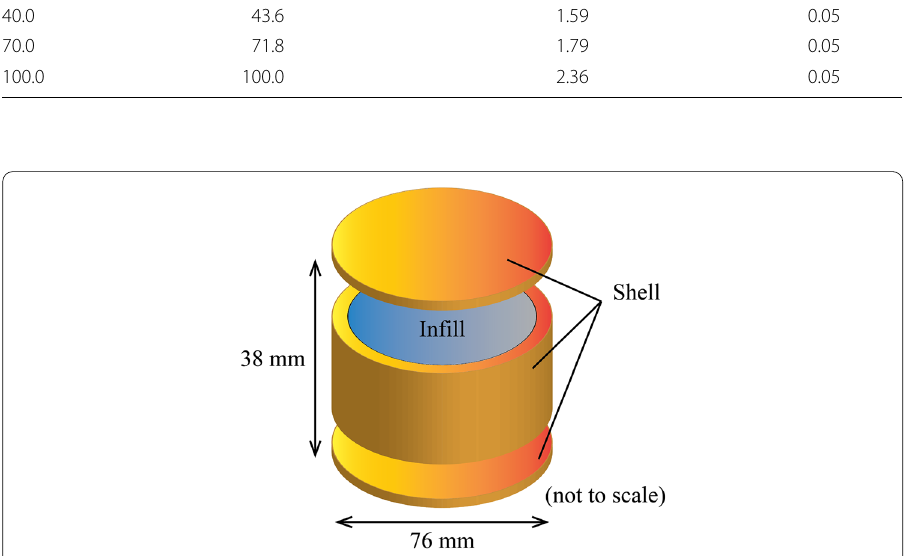
Fig. 5 Schematic of the 3D-printed TPU with shells used for dielectric